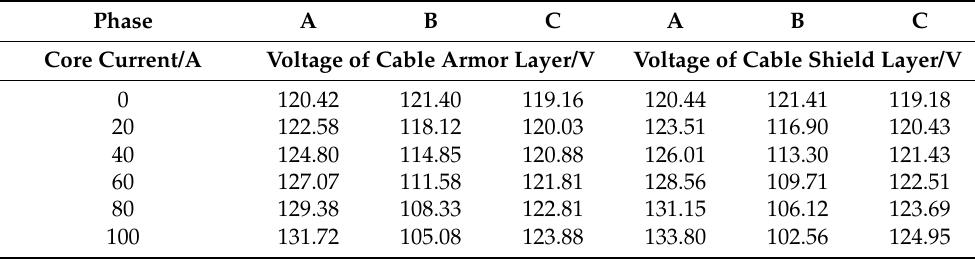
Table 8. Simulation value of induced voltage of metal sheath with a separate sheath protector when there are four vehicles.